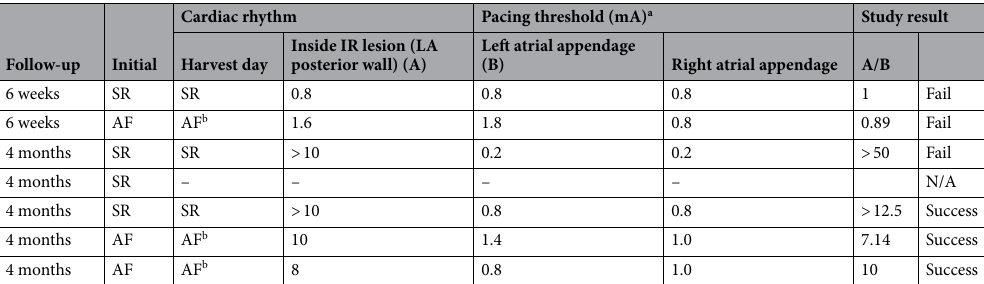
Table 1. Study results. SR sinus rhythm, AF atrial fibrillation, IR irradiated, LA left atrial, N/A not applicable. a Pulse width 1.0 ms. b Pacing threshold test was performed under sinus rhythm after direct current cardioversion.